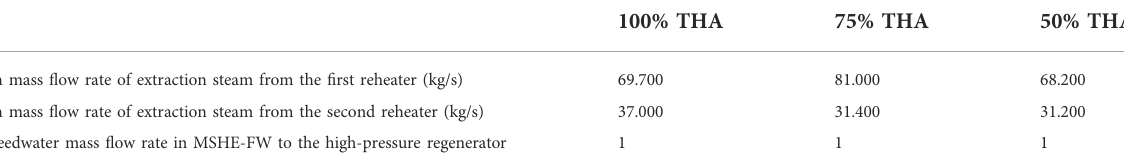
TABLE 3 Maximum extraction steam mass fl ow rates in different loads in the TSACPG system.